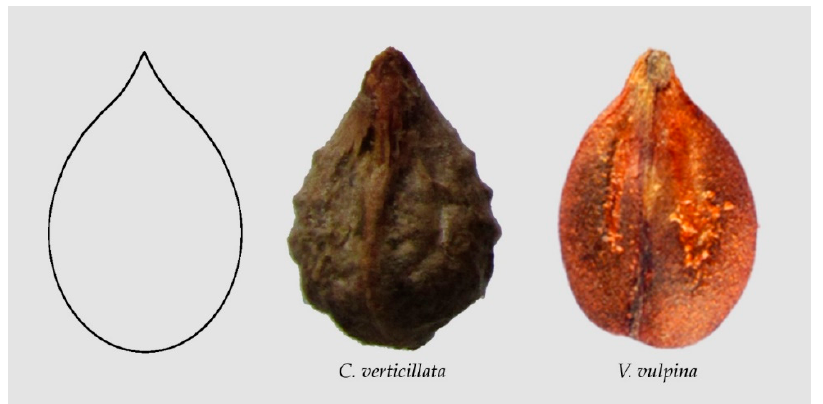
Figure 3. Examples of seed images resembling elongated water drops. From left to right: The model for an elongated water drop (Model 4 in [45]), seeds of Cissus verticillata and Vitis vulpina .